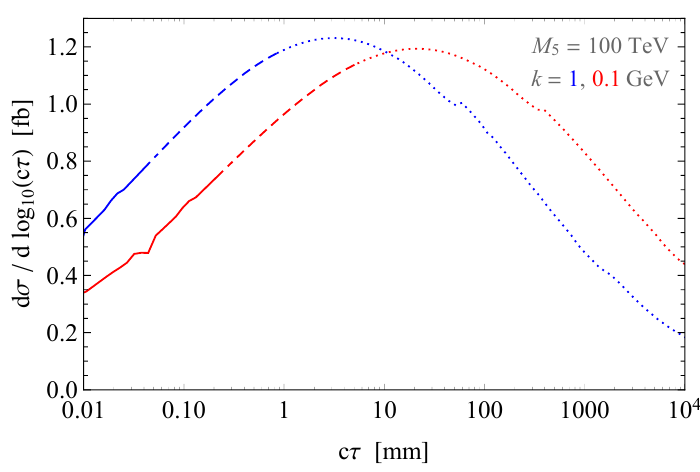
Figure 22 . KK gravitons resonant production cross section at the 13 TeV LHC, di(cid:11)erential in the mode lifetimes, for M 5 = 100 TeV and k = 1 GeV (blue) and 0 : 1 GeV (red). Dotted segments indicate very light modes ( m < 40 GeV) which will likely be di(cid:14)cult to see, dashed segments describe intermediate masses (40 < m < 100 GeV), while solid segments describe heavy KK modes ( m > 100 GeV). For higher values of M 5 , all the displacements would be larger (behaving approximately as c(cid:28) / M 3 ), but the production cross sections would be smaller (behaving approximately as 5 (cid:27) / 1 =M 3 5